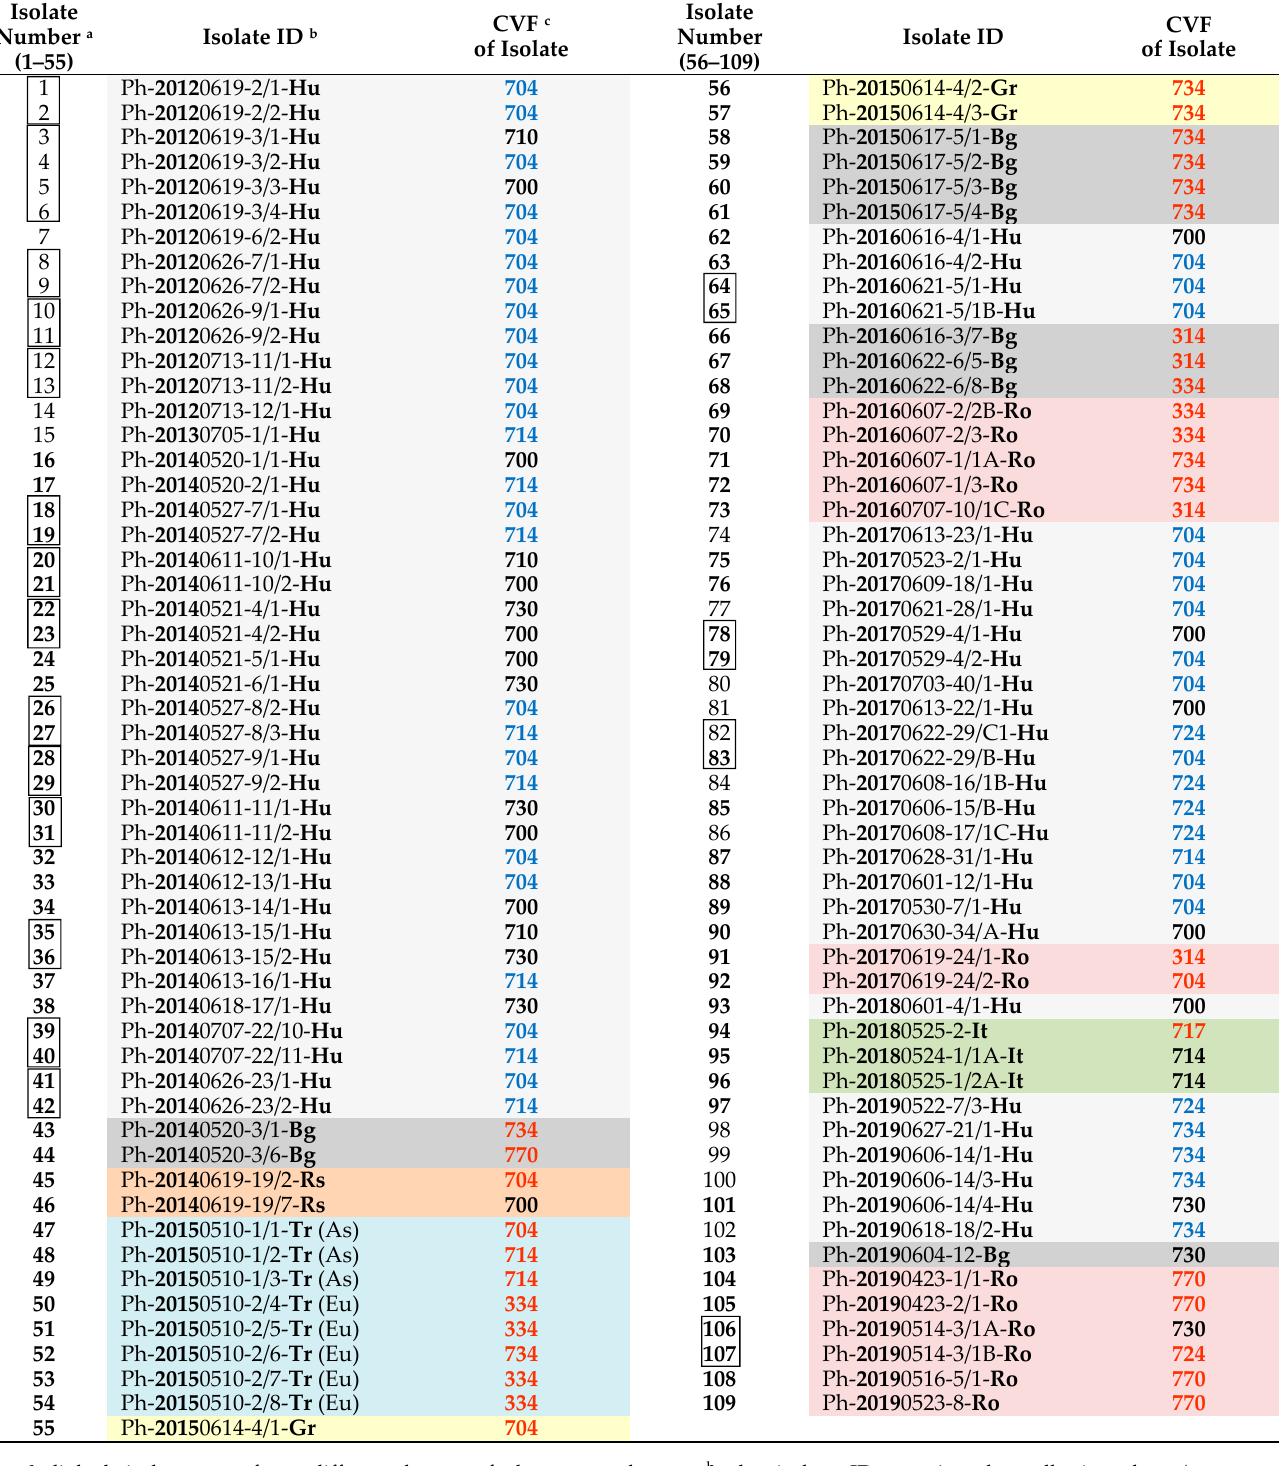
Table 3. Virulence character of Plasmopara halstedii isolates collected from seven countries in Europe (2012–2019). Isolate Number